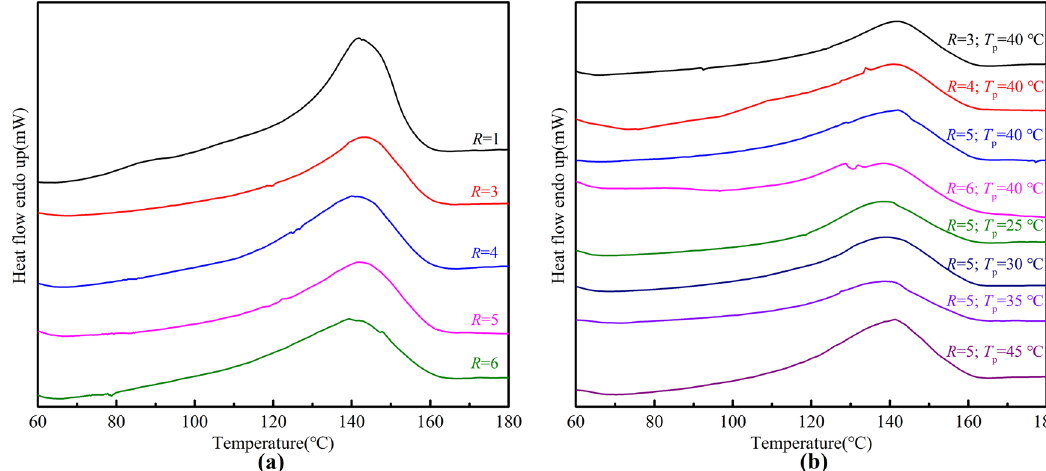
Figure 7: DSC thermograms of PVDF - HFP fi lms: ( a ) stretched PVDF - HFP fi lms at various elongation ratios; ( b ) stretched plus poled PVDF - HFP fi lms at various elongation ratios ( T = 40°C ) and various poling temperatures ( R = 5 ) p